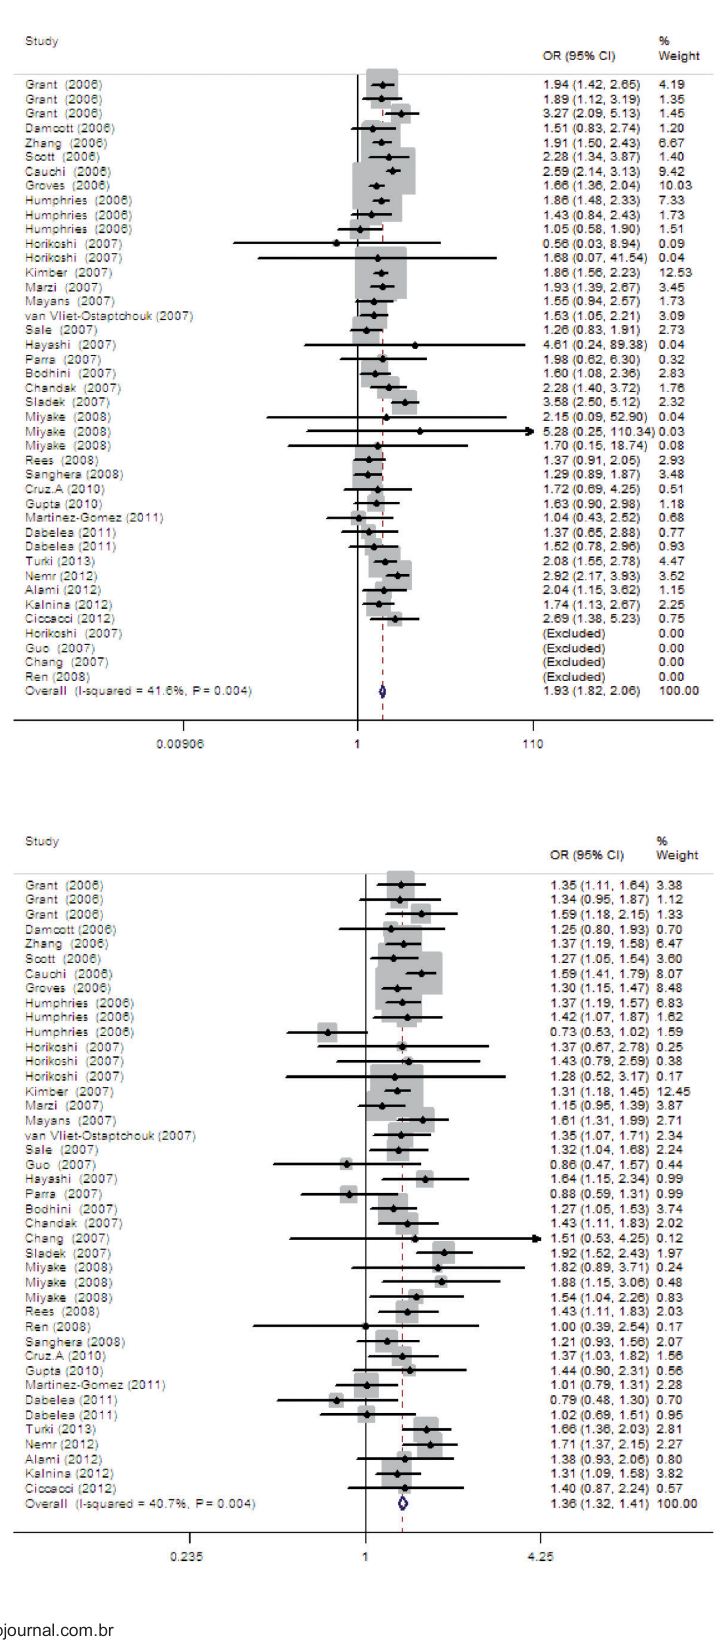
Figure 2. Meta-analysis of the associa- tion between type 2 diabetes and the TT genotype of rs12255372.